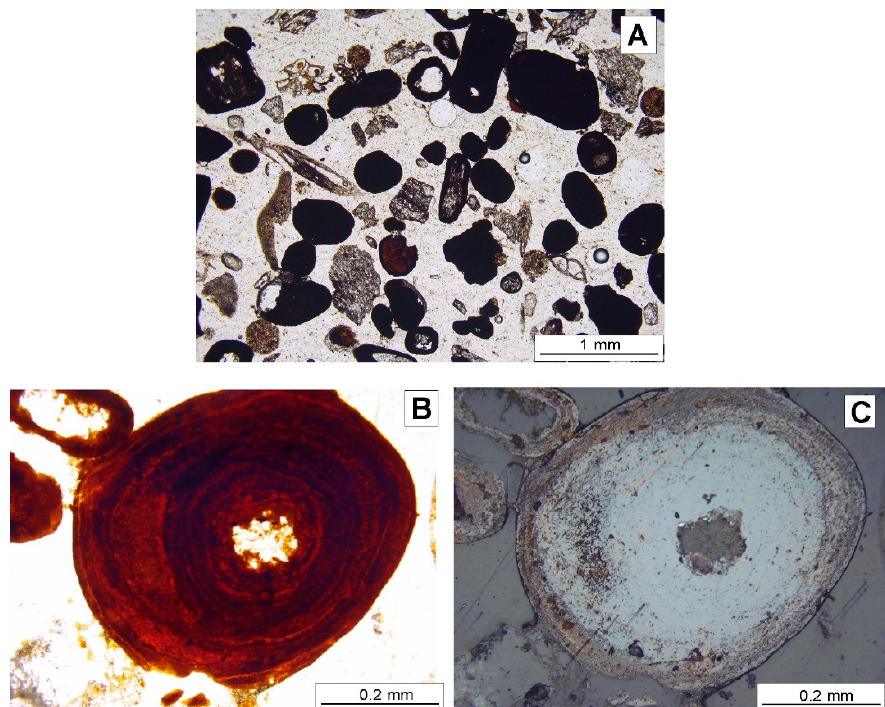
Figure 5. Terrestrial iron spherules from Panarea (Aeolian Archipelago, Mediterranean Sea). The newly formed ooids are associated to a hydrothermal origin. ( A ) Transmitted-light photomicrograph of thin-sectioned material illustrating main ooidal morphologies. ( B ) Transmitted- and ( C ) reflected-light photomicrographs of a thin-sectioned ooid with goethite lamination around an indistinct nucleus. Photos B and C courtesy of F. Messori.